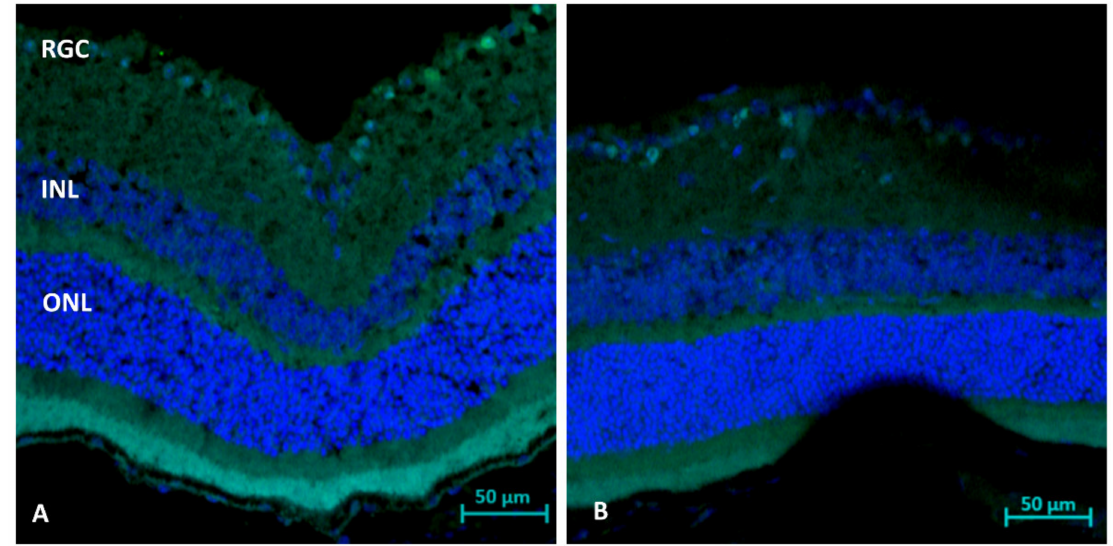
Figure 2. Immunohistochemistry analysis (day 3) for apoptosis (TUNEL). Note stained apoptotic RGC cells following ONC only ( A ), with reduced apoptosis following AZ treatment ( B ).